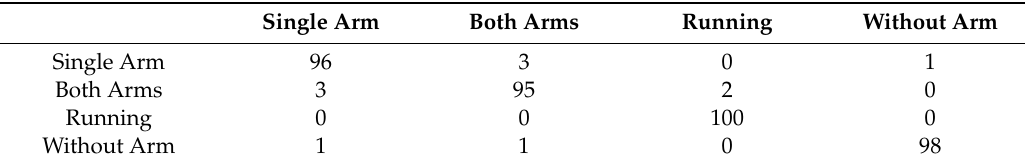
Table 1. Confusion matrix results of the proposed